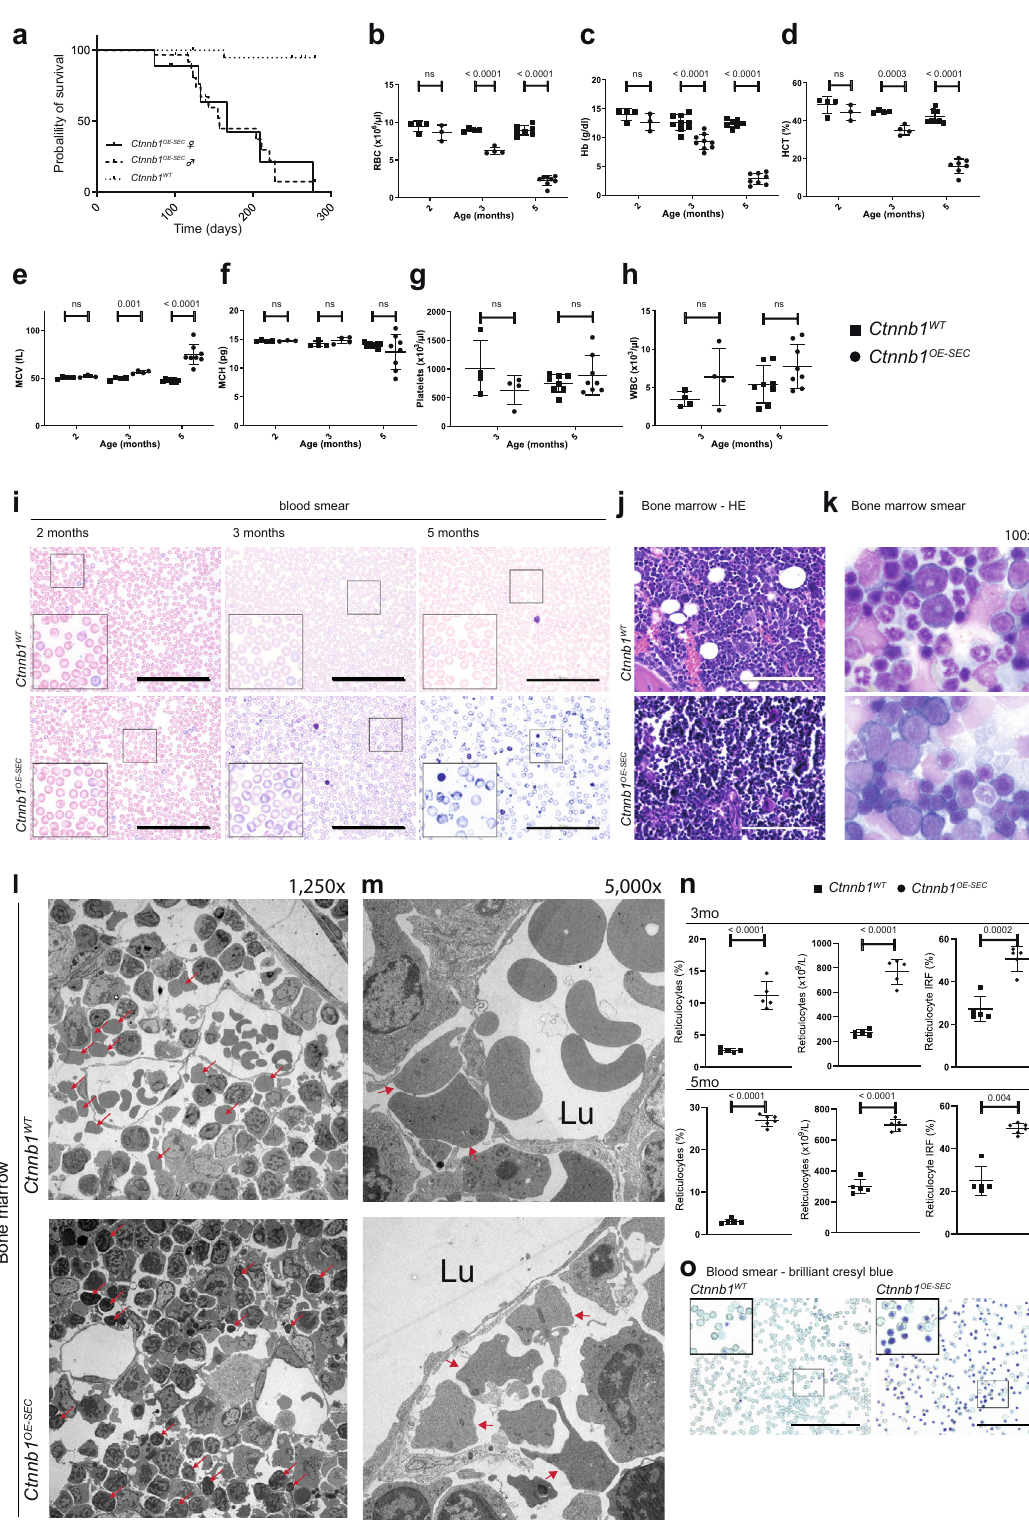
LDH or K + levels in Ctnnb1 OE-SEC mice (Supplementary Fig. 2c – e). White blood cell counts and platelets were normal (Fig. 2g, h and Supplementary Fig. 2f, g). Peripheral blood smears of Ctnnb1 OE-SEC mice revealed striking polychromasia starting at 2 – 3 months of age indicating premature release of red blood cells in the bloodstream; in addition, scattered fragmen- tocytes were found (Fig. 2i). BM histology (Fig. 2j) and smears